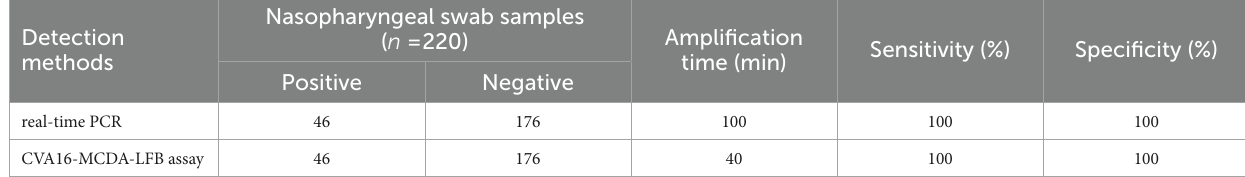
TABLE 3 Comparison of real-time PCR and CVA16-MCDA-LFB methods to identify CVA16 in clinical samples.